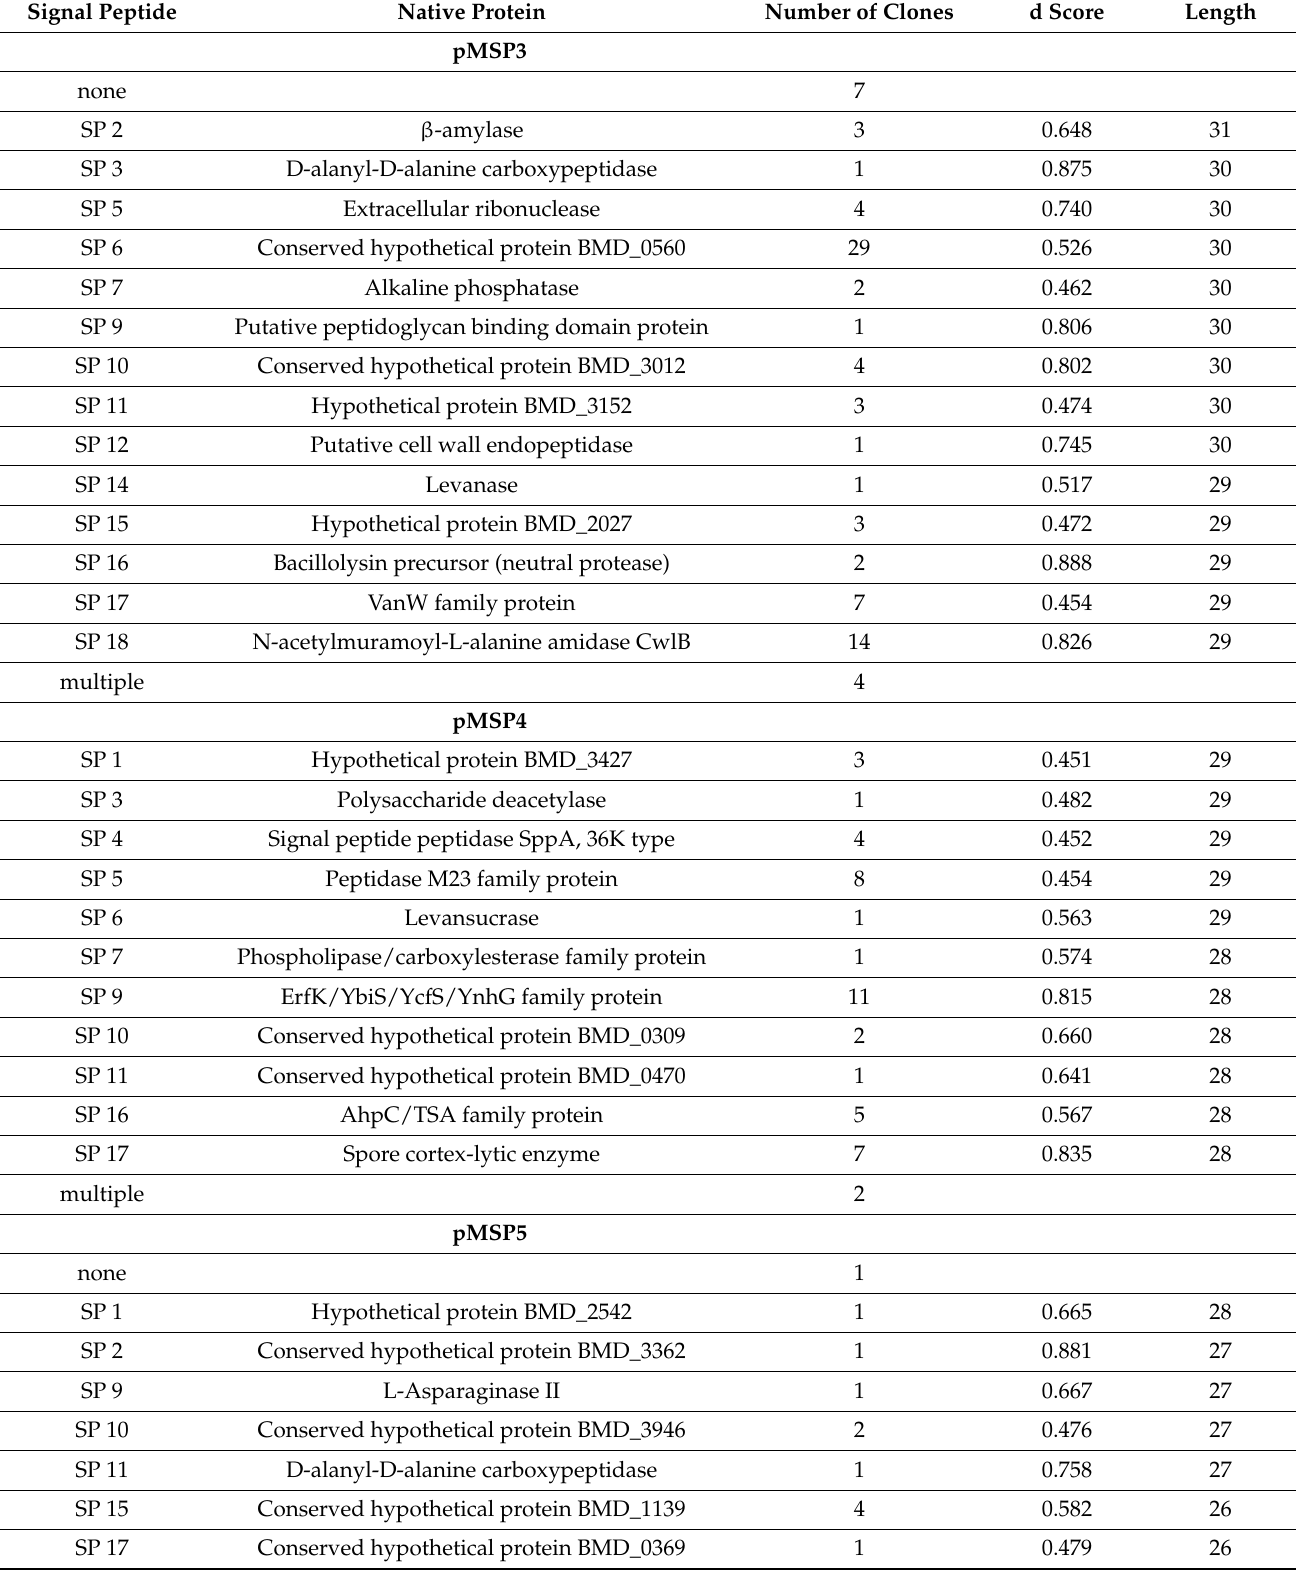
Table 2. Identity of SPs of pMSP3–5 that led to secretion of